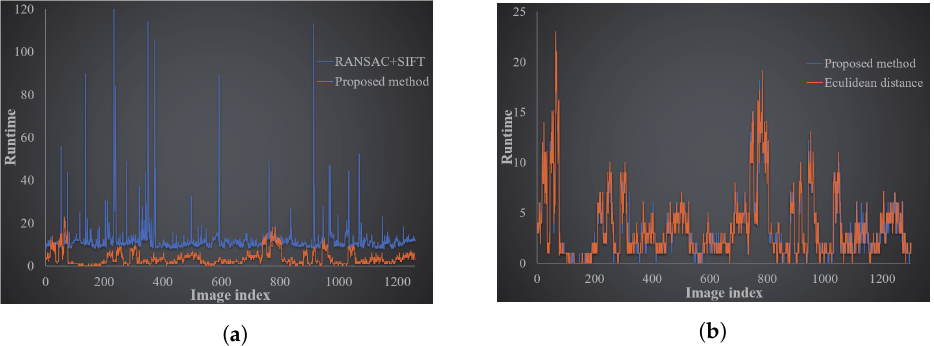
Figure 14. Comparison of three methods on runtime. ( a ) Runtime of RANSAC+SIFT method and our proposed matching method. ( b ) Runtime of Euclidean distance method and our proposed matching